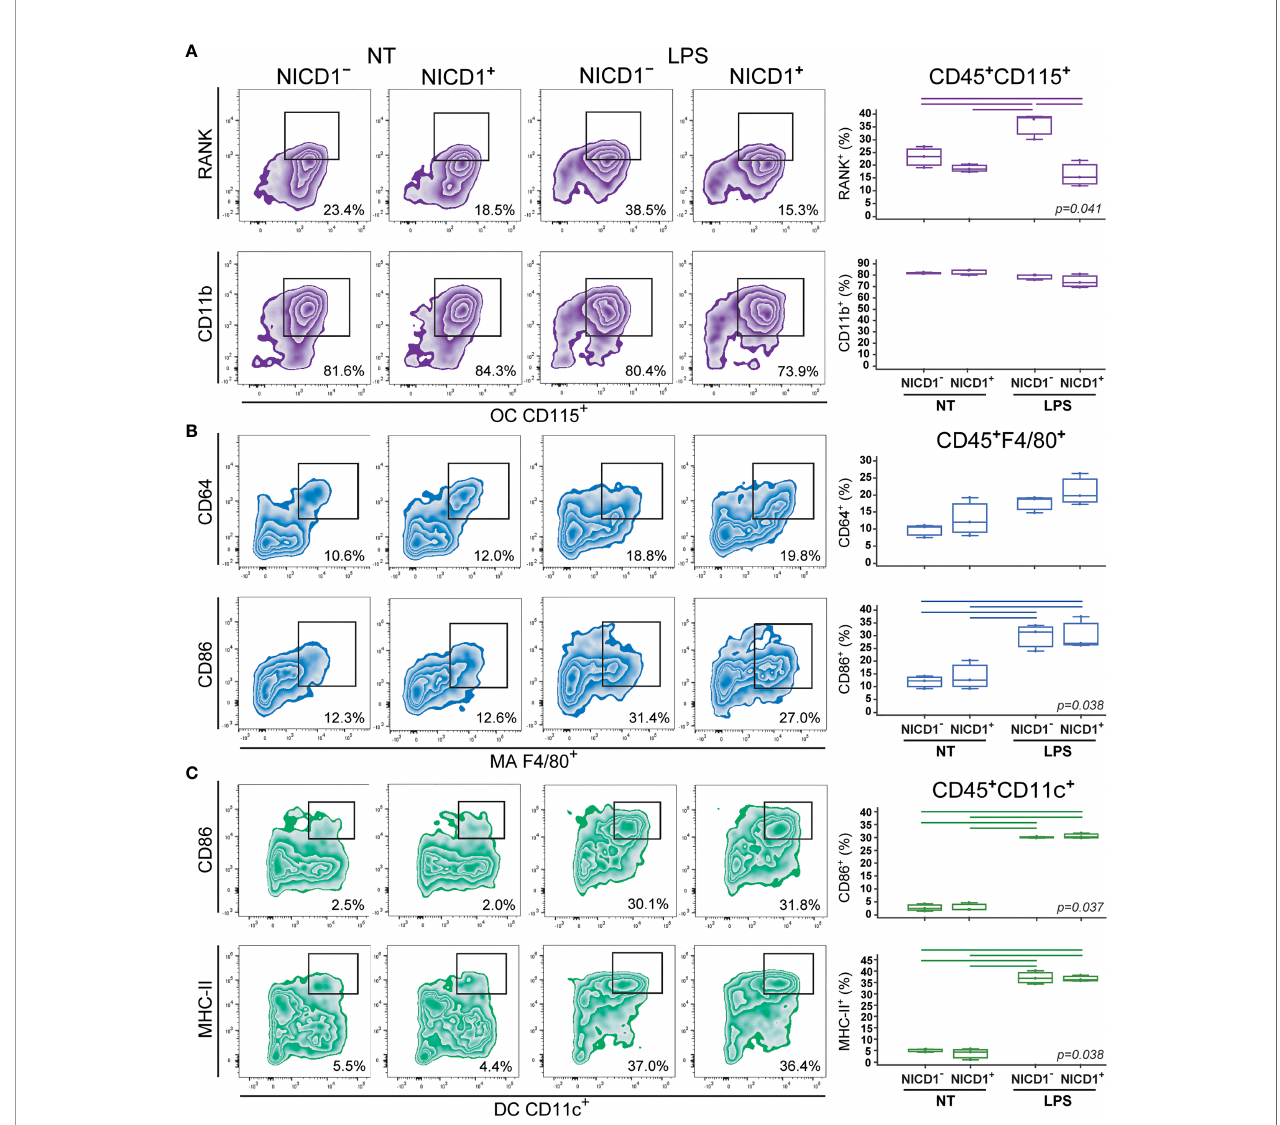
FIGURE 3 | Phenotype of osteoclasts (OCs), macrophages (MAs) and dendritic cells (DCs) differentiated from the common trilineage progenitor (TLP) of CX3CR1CreERT2/ NICD1 mice. Bone marrow cells were fl ushed from hind limb long bones and the common TLPs were identi fi ed as CD45 + Ly6G − CD3 − B220 − NK1.1 − CD11b – /lo CD115 + cells using fl ow-cytometry. TLPs were sorted and plated under appropriate culture conditions. Differentiation of OCs was induced by receptor activator of nuclear factor k B ligand (RANKL) and macrophage colony-stimulating factor (M-CSF); MAs by M-CSF; DCs by interleukin 4 (IL-4) and granulocyte-macrophage colony-stimulating factor (GM-CSF). Cre-mediated recombination in Cre + (NICD1 + ) littermates was induced by the addition of 4-hydroxytamoxifen (4-OHT). Cre − (NICD1 − ) littermates treated with 4-OHT were used as controls. Lipopolysaccharides from E.coli (LPS) were added 12h before harvesting, to induce the in fl ammatory response; non-treated (NT) cells were used for comparison. Cells were harvested at culture day 2. (A) Expression of RANK and CD11b on CD115 + osteoclast-committed progenitors stimulated by LPS. Representative dot plots showing RANK + CD115 + and CD11b + CD115 + subpopulations. (B) Expression of CD64 and CD86 on F4/80 + macrophage-committed progenitors stimulated by LPS. Representative dot plots showing CD64 + F4/80 + and CD86 + F4/80 + subpopulations. (C) Expression of CD86 and MHC-II on CD11c + dendritic cell-committed progenitors stimulated by LPS. Representative dot plots showing CD86 + CD11c + and MHC-II + CD11c + subpopulations. (A – C , right ) Individual values of biological triplicates are presented; horizontal lines represent the median, boxes represent the interquartile range (IQR), whiskers represent 1.5 times the IQR. Statistically signi fi cant difference was determined at p<0.05, Kruskal – Wallis test followed by Conover test for group-to-group comparisons (lines denote signi fi cant difference between